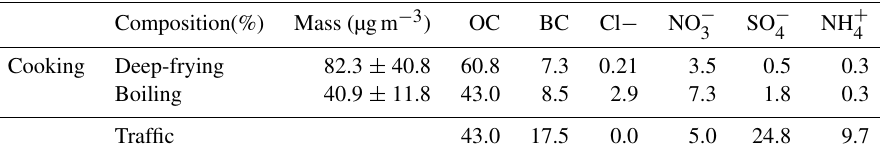
Table B1. Chemical compositions for cooking (See and Balasubramanian, 2008) and traffic (Yubero et al., 2015) emissions. In the former case, a gas stove is assumed.